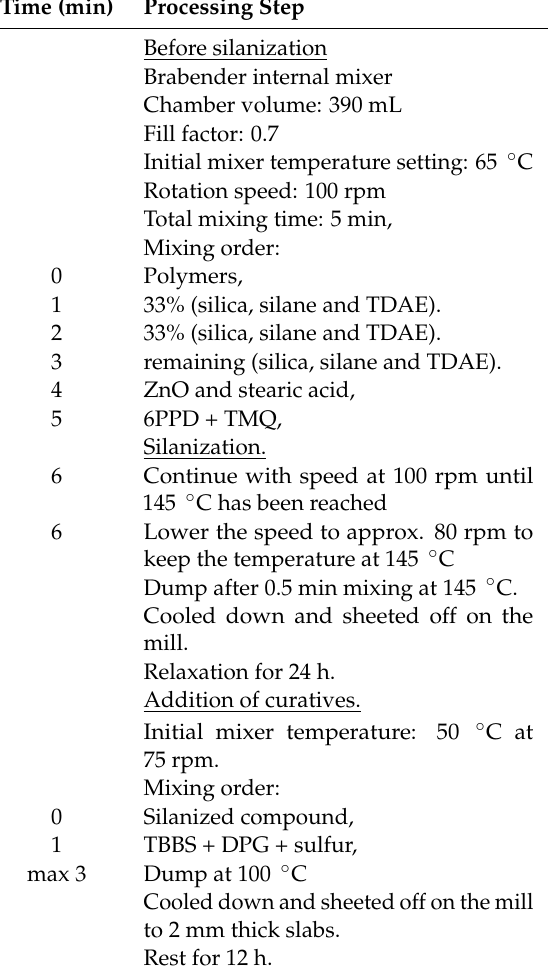
Table 6. Preparation procedure for silica-based tire tread